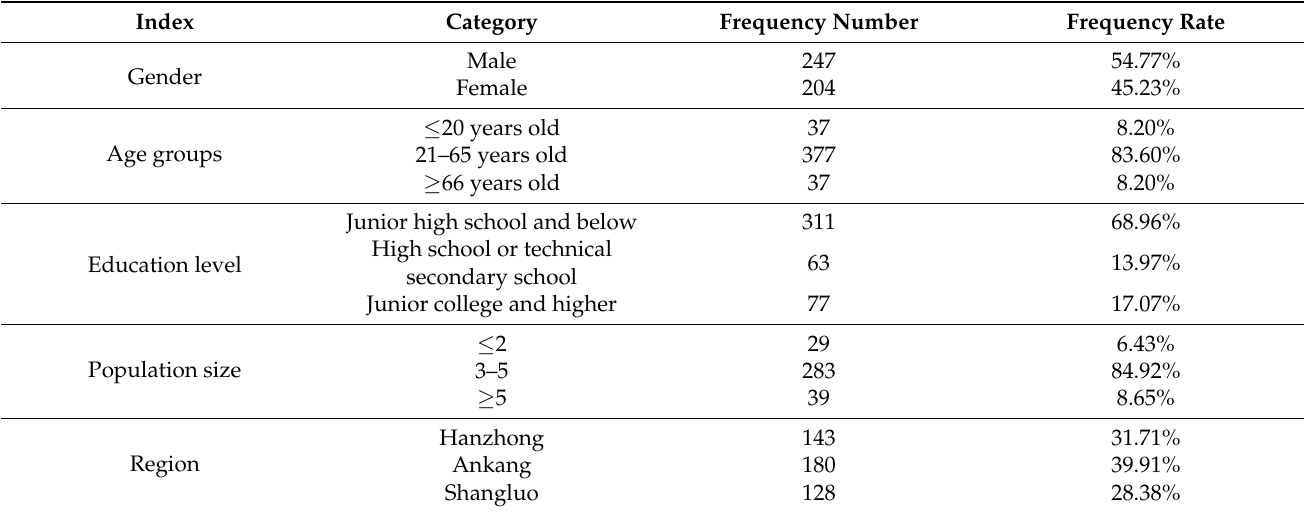
Table 1. Basic information of